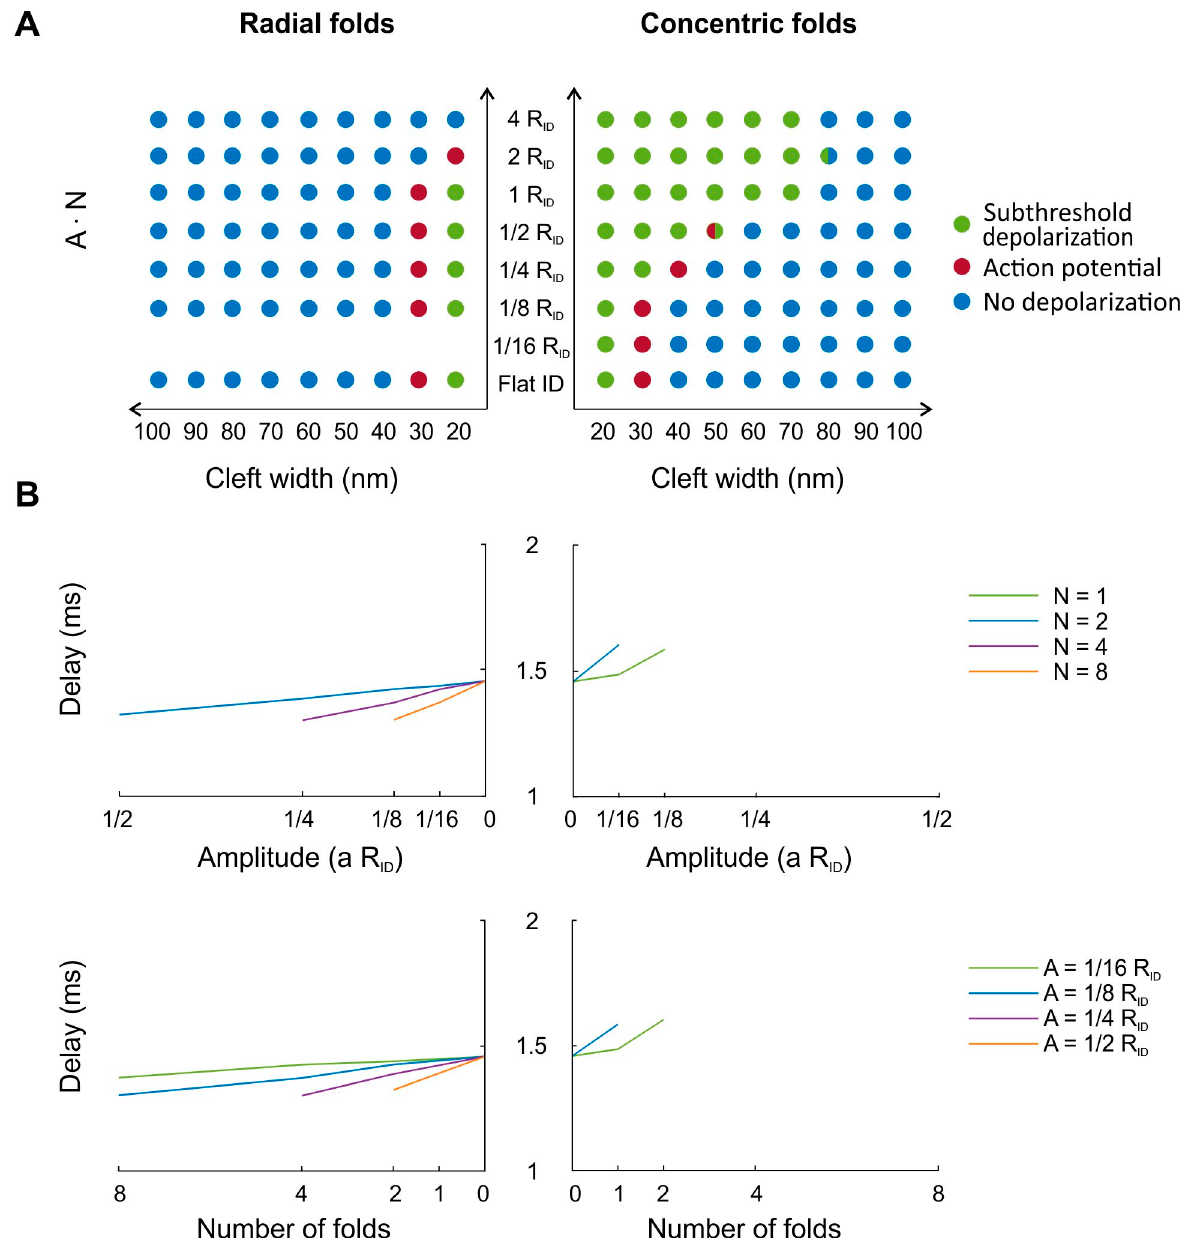
Figure 8. Comparison of the effects of concentric and radial folds in the presence of clustered Na+ channels in the center of the intercalated disc (Rc = 1/8 R ID ). ( A ) Response of the post-junctional cell for radial (left) and concentric folds (right) and for different combinations of cleft width and tortuosity (i.e., value of A · N). The responses were categorized as subthreshold depolarization (green), action potential (red) or no depolarization (blue). Note that for some combinations of A and N, two different responses occurred (double-colored dots). Note also that for radial folds, simulations with A · N = 1/16 R ID were not run because this involves simulations with N = 1 (which corresponds to an oblique but flat intercalated disc). ( B ) Delay (measured at Vi = 0 mV) between the action potential upstrokes of the pre- and post-junctional cells for radial (left) and concentric folds (right) as a function of A and N. The cleft width was set to 30 nm. The zero on the abscissas correspond to the flat intercalated disc.